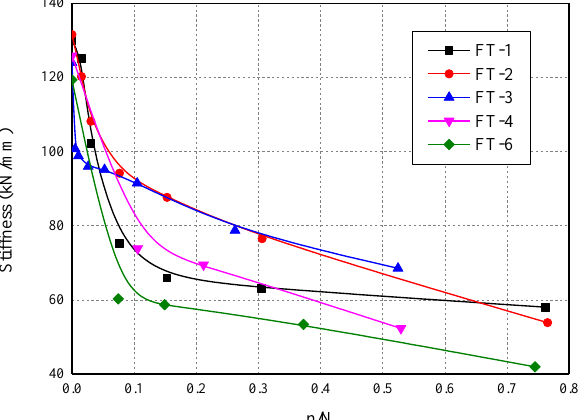
Figure 10. Secant bond sti ff ness in normalized fatigue cycles.